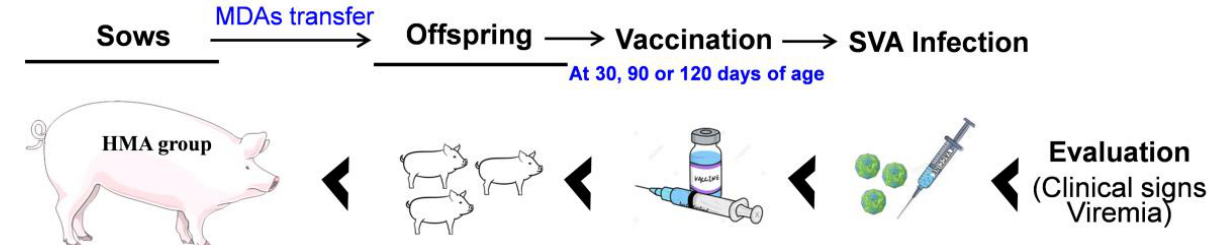
Figure 6. Schematic representation of infection of the offspring in the HMA by SVA. Table 1. The clinical signs and viremia state in the offspring infected by SVA. Clinical Signs Viremia Offspring (Fluid-Filled Vesicles and Ulcerative Lesions) (Cut-Off CT Value Is 35) No. #4 + + No. #5 − − No. #6 −